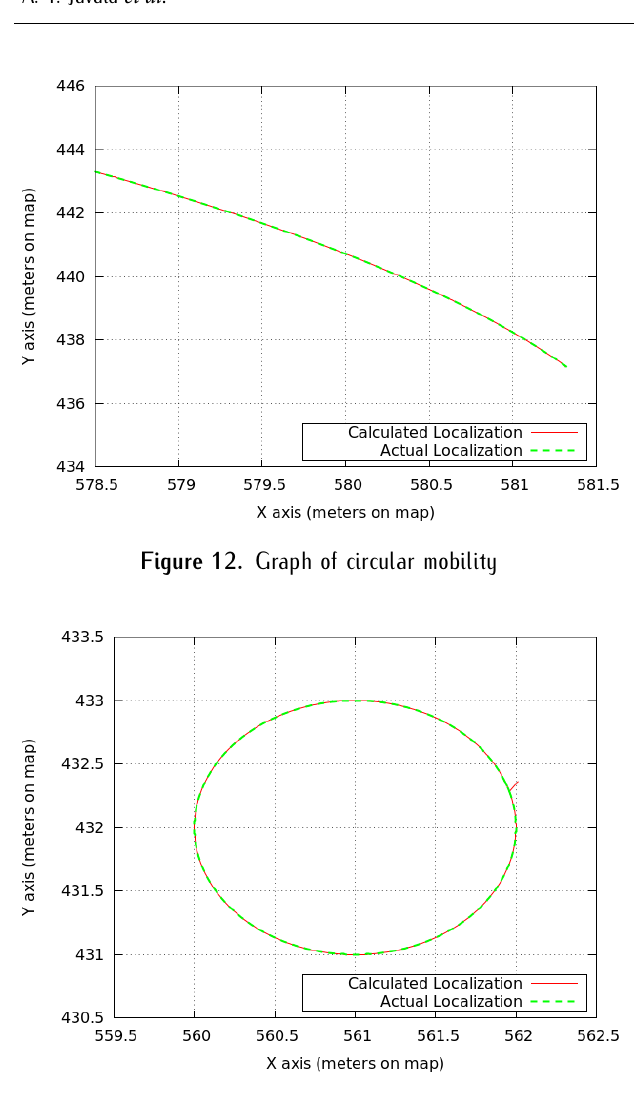
Figure 13. Graph of complete trajectory of circular mobility